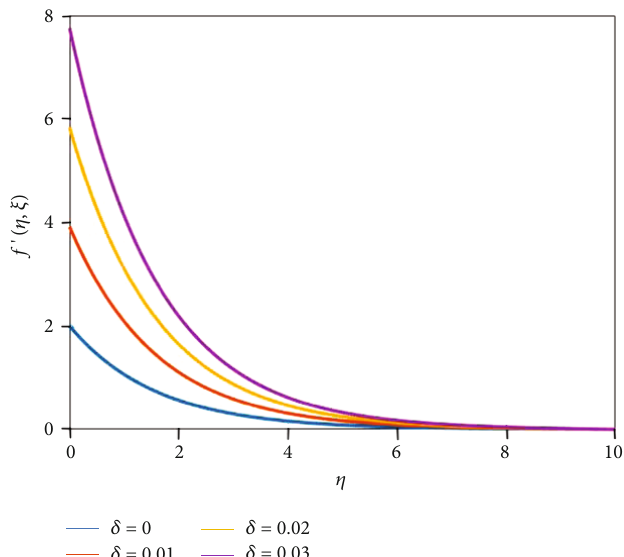
: 8, ξ = 1, N N Df = Bi = Sr = 0 : 5, He = δ = NR b = t = w = 0